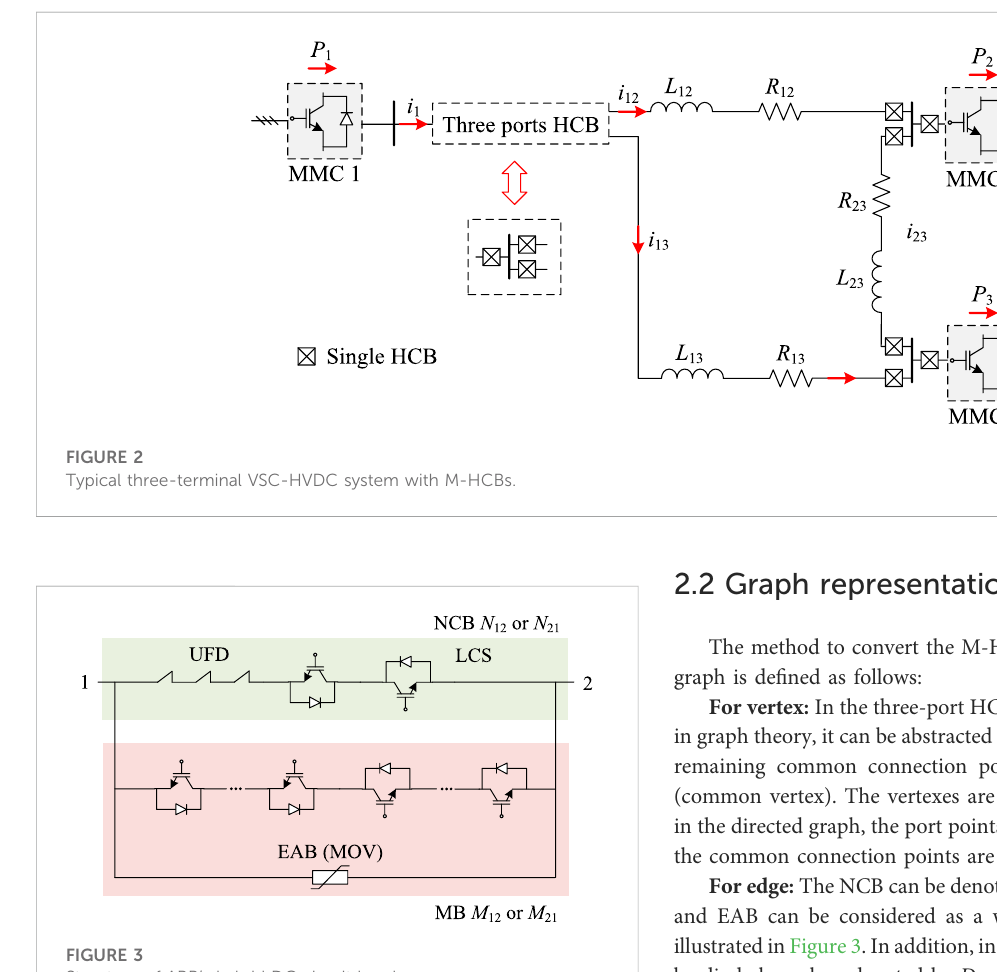
FIGURE 3 Structure of ABB ’ s hybrid DC circuit